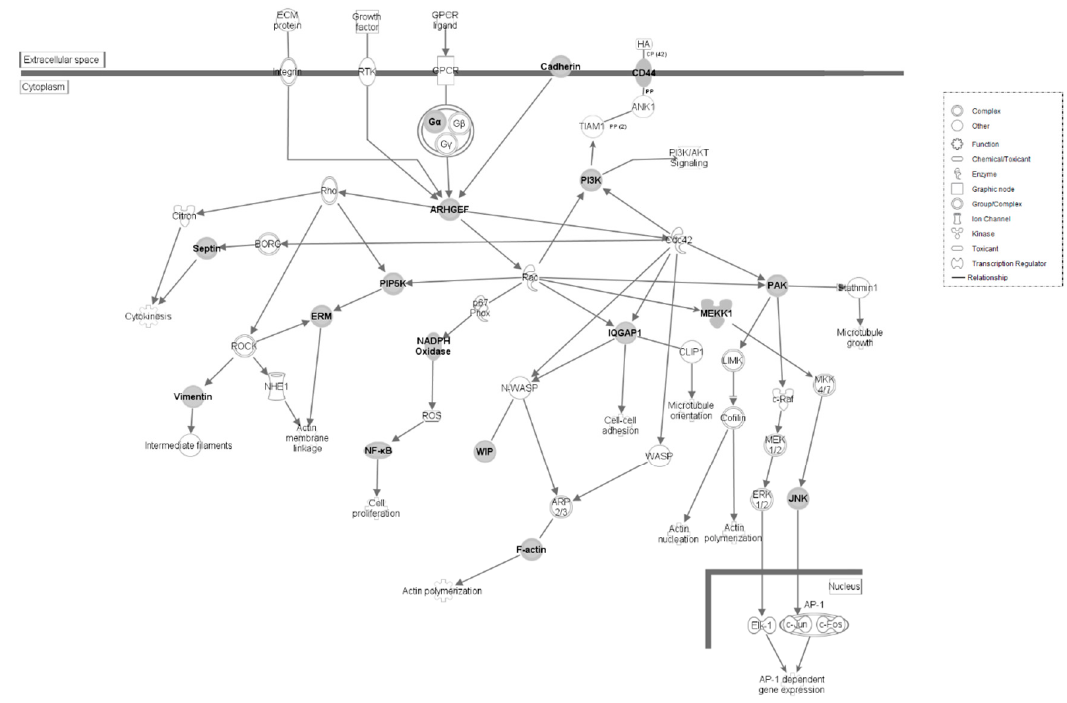
Figure 5 . Signaling by Rho Family GTPases and Rac Signaling Pathways in HS line of Japanese quail. Molecular interaction and symbols are the same as described in Figure 3.